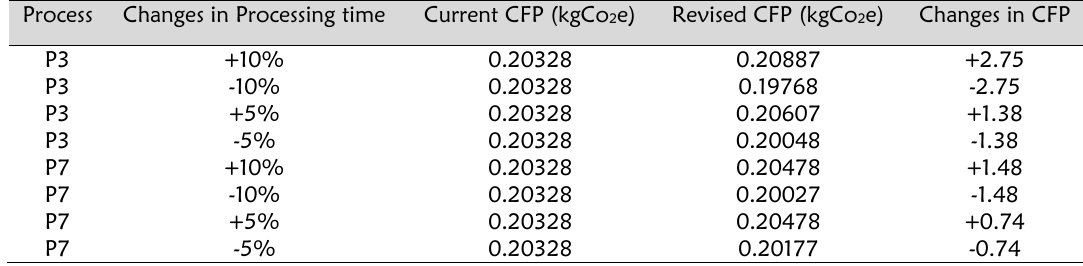
Table 6: Computed values for sensitivity analysis.